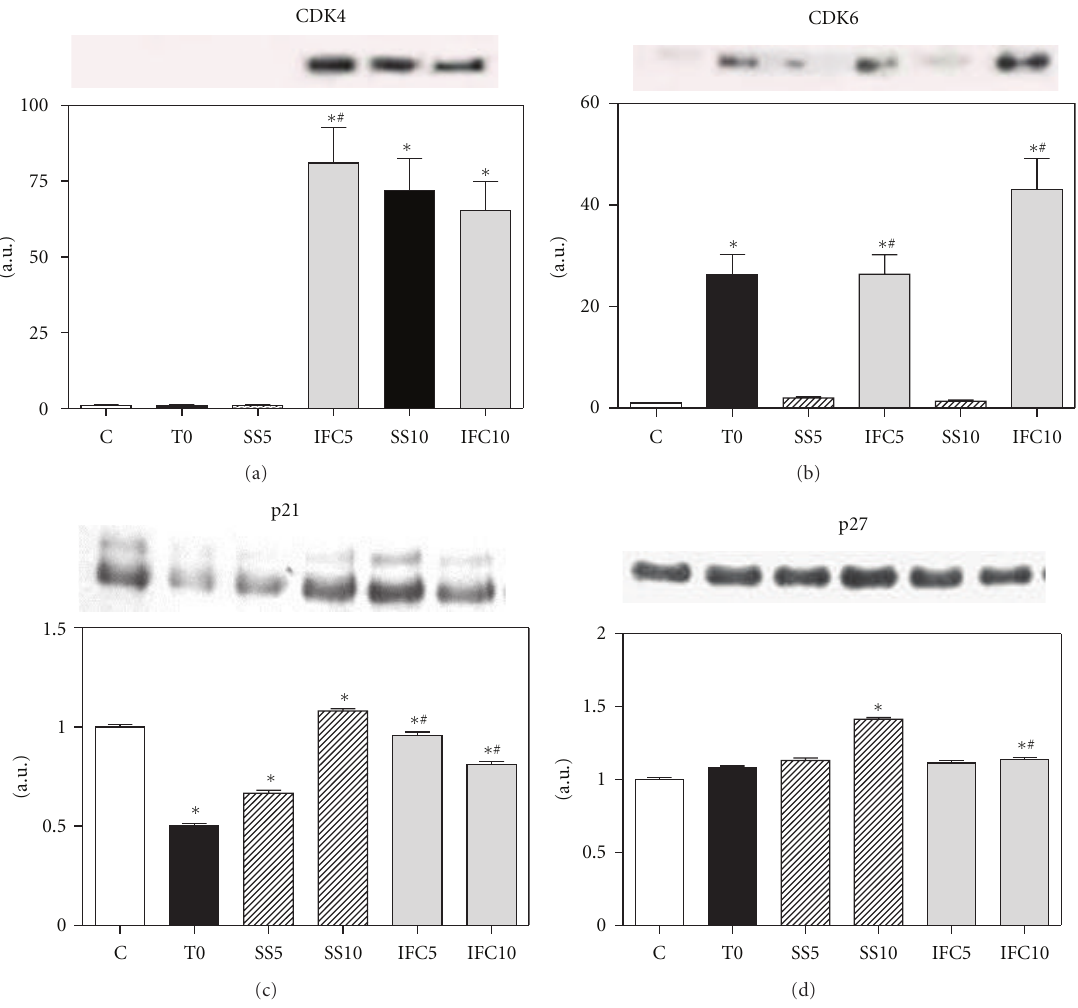
Figure 3: E ff ect of IFC305 treatment on CDK4, CDK6, p21, and p27 proteins expression in cirrhotic livers. (a), (b), (c), and (d) Expression of the indicated proteins from liver nuclear extracts was done by western blot analysis. A representative western blot image is shown. The bar graph represents the densitometry analysis expressed as arbitrary units of the mean ± SEM from 3 rats/group; values were normalized to β - actin immunodetection (image, Figure 1(a)). ∗ Statistical di ff erence ( P < 0 . 05) when compared to C group. # Statistical di ff erence ( P < 0 . 05) when compared to their respective experimental group SS5 or